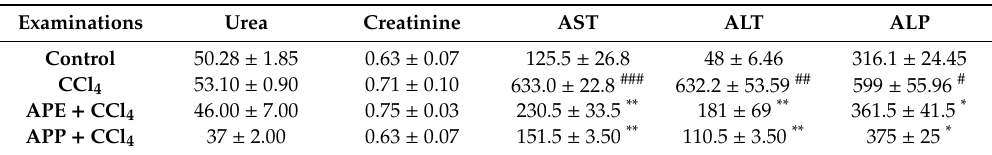
Table 1. E ff ects of APE and APP on serum biochemical parameters a in CCl 4 -induced hepatic damage Table 1. Effects of APE and APP on serum biochemical parameters a in CCl 4 ‐ induced hepatic damage in in rats.